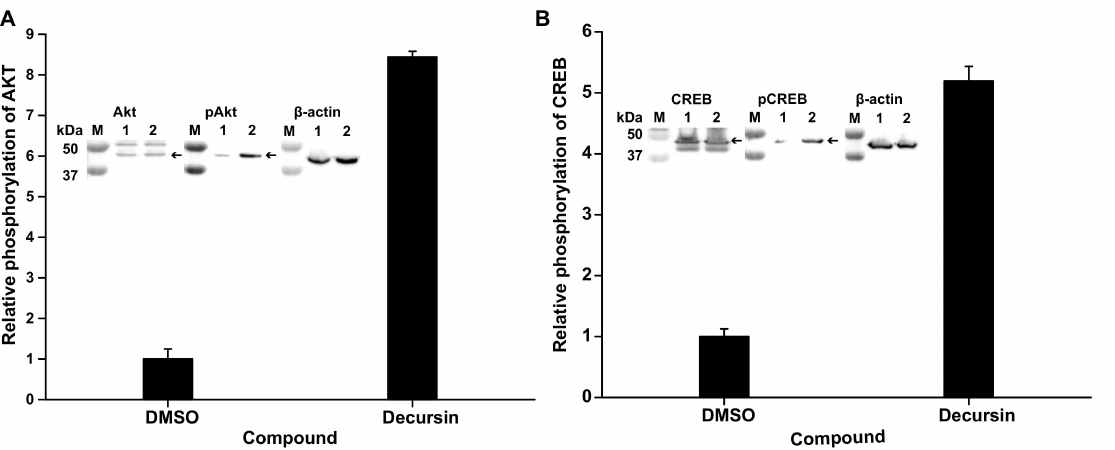
Figure 5. The phosphorylation of Atk and CREB following decursin treatment. ( A ) The phosphorylation of Akt in the presence of 2 µ M decursin. ( B ) The phosphorylation of CREB in the presence of 2 µ M decursin. Inlet pictures indicate immunoblotting results for Akt, phosphorylated Akt (pAkt), CREB, pCREB, and β -actin as a house-keeping protein. M, 1, and M2 indicate the protein size marker, the cell lysate without, and with decursin,